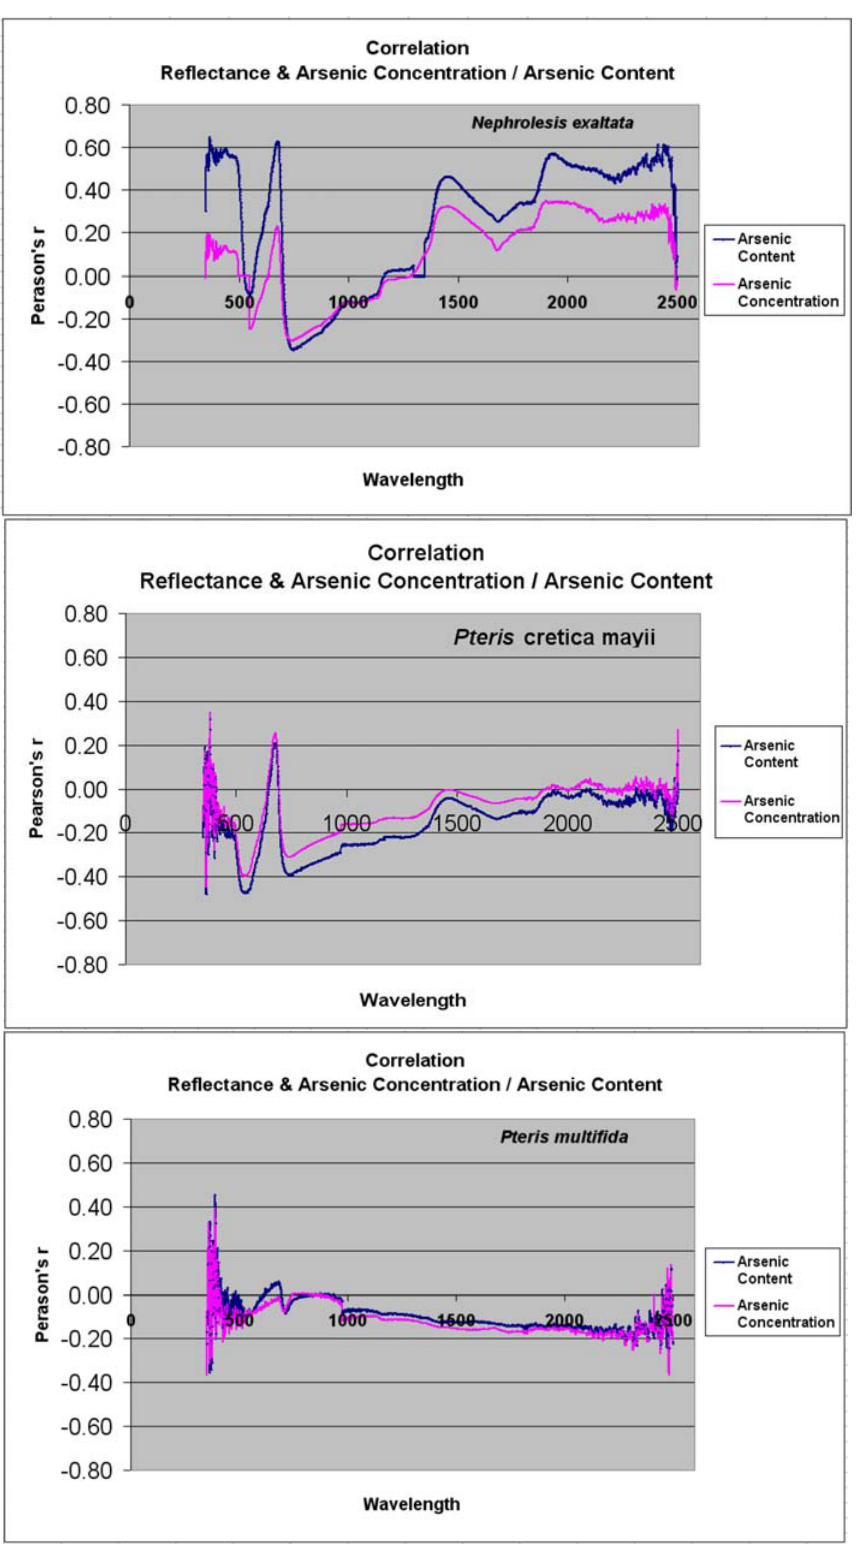
Figure 9. Wavelength - arsenic correlations. The first data visualization investigates the correlation between the average spectral reflectance and arsenic concentration and content, thus showing the areas of the spectrum that might yield information about the levels of arsenic in the